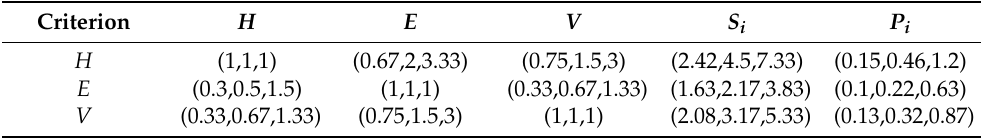
Table 1. The construction of fuzzy judgment matrix in criterion layer. Criterion